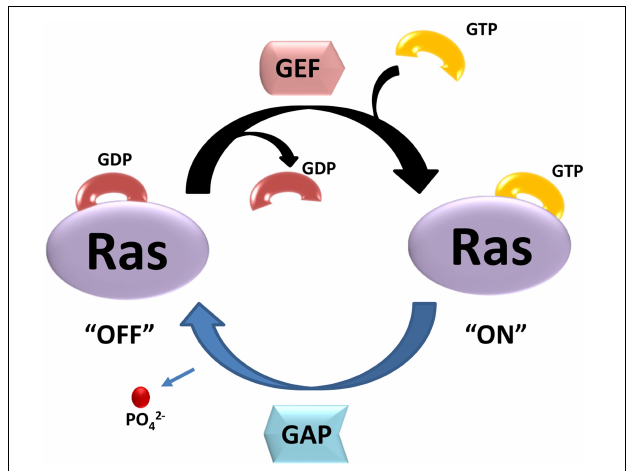
FIGURE 1 | The two state of small GTPases. GTP- and GDP-bound state are regulated by GEFs and GAPs. GEFs stimulate the exchange of GDP for GTP, resulting activation of Ras (“ON”). GAPs promote GTP hydrolysis, and return Ras to GDP-bound state